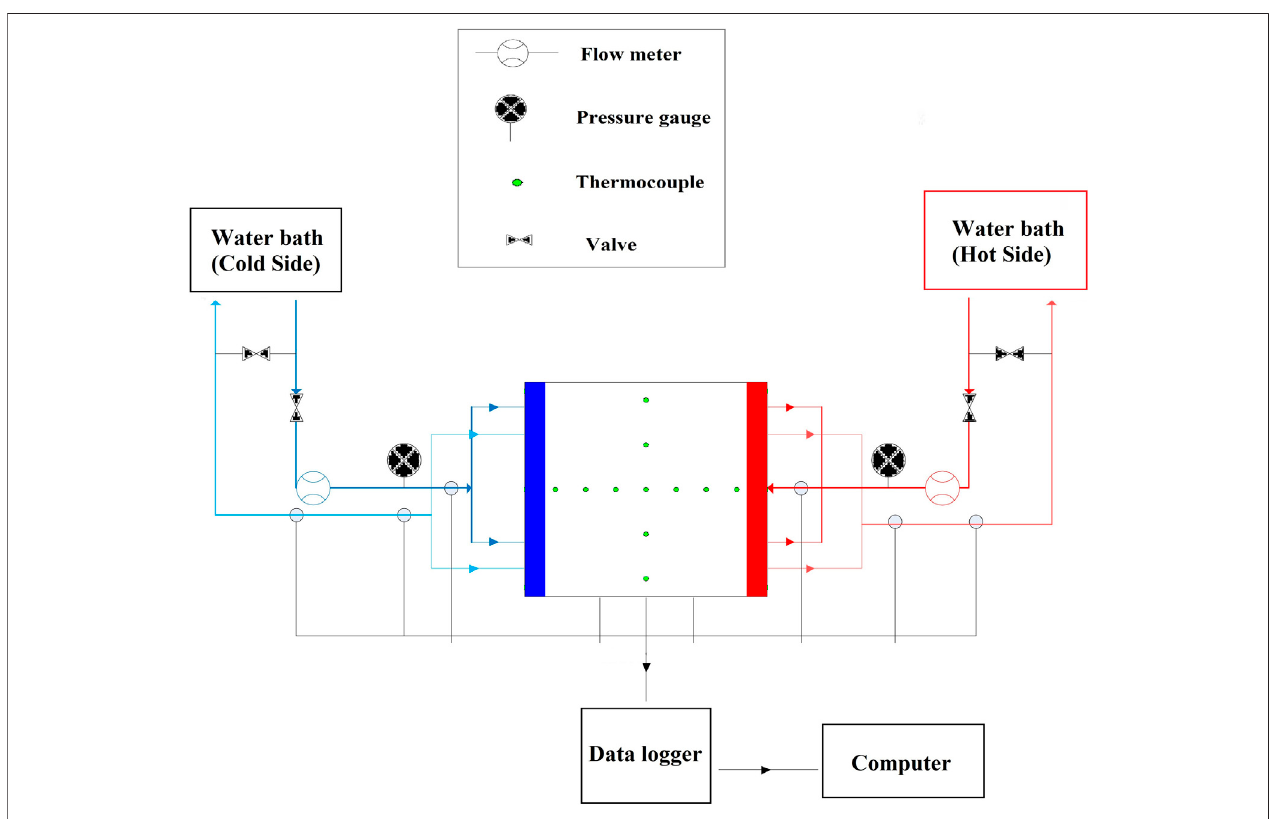
FIGURE 1 | Cavity-set-up to study the natural convection of the nano fl uids.